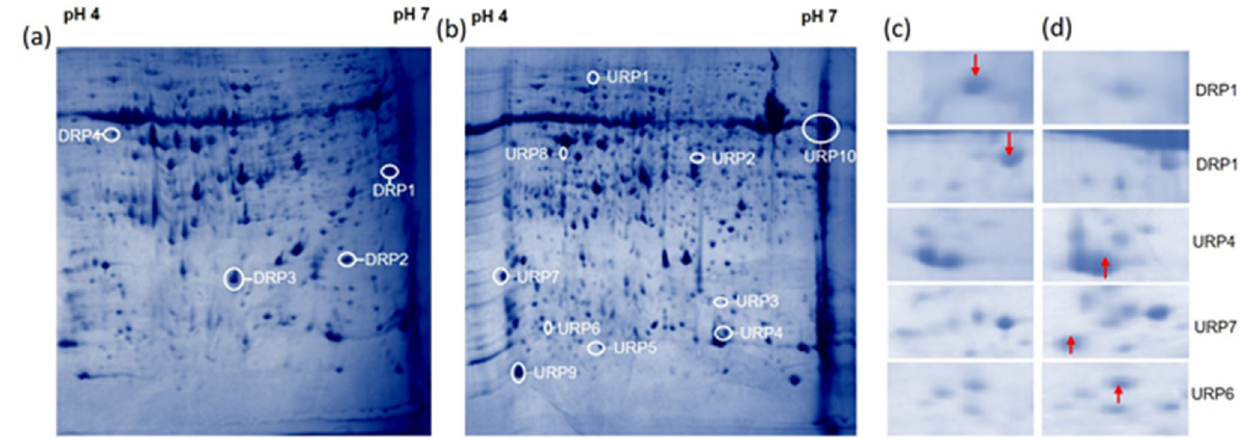
Figure 3. R. solani -induced proteome shift in cultivated rice cv. Pusa Basmati-1: Total proteins were extracted from cultivated rice cv. Pusa Basmati-1 and analyzed by 2-DE protein electrophoresis. In panel ( a ): complete 2D protein profile of cultivated rice cv. Pusa Basmati1 without R. solani infection. In panel ( b ): complete 2D protein profile of cultivated Pusa Basmati-1 48 h post-inoculation of R. solani . The spots which were more intense in the control are shown with a downward arrow ( ↓ ), and the spots which were more intense in the stressed cells are shown with an upward arrow ( ↑ ). After image analysis, 67 spots were found to be differentially expressed quantitatively between the two situations. In panels ( c , d ) are some of the representative differentially expressed enlarged regions of the protein profile from panels ( a , b ). Here, URP and DRP represent the up-regulated and down-regulated protein spots,